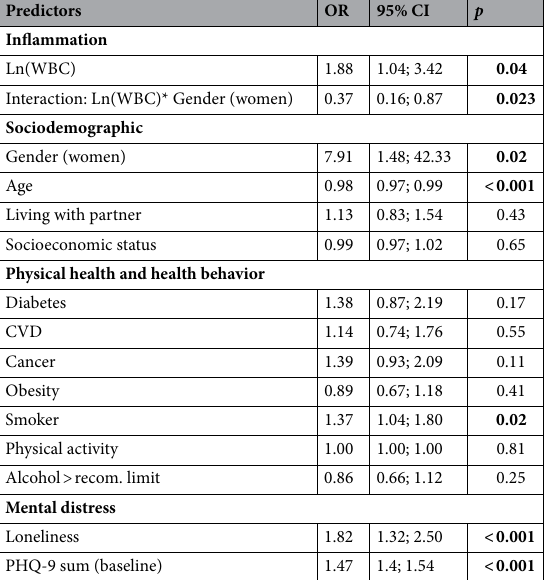
Table 4. Results of the logistic regression analysis: Prediction of new onset of depression at follow-up (based on predictors measured at baseline 5 years earlier, including the natural logarithm of WBC). Bold values indicate statistically significant predictors. Total model: Nagelkerke R 2 = 0.37. CI confidence interval, CVD cardiovascular disease, OR odds ratio, PHQ‑9 patient health questionnaire-9, WBC white blood cell